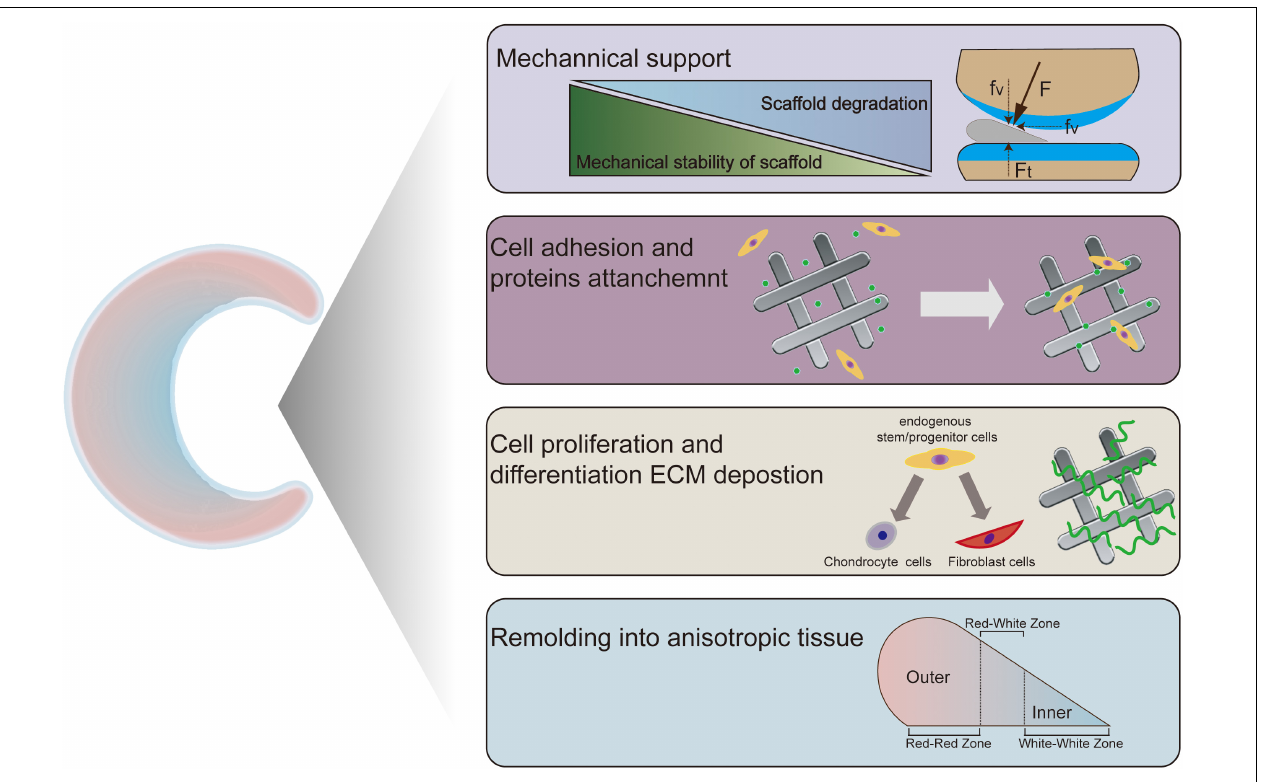
FIGURE 2 | Key steps controlled/promoted by tissue-engineered meniscal